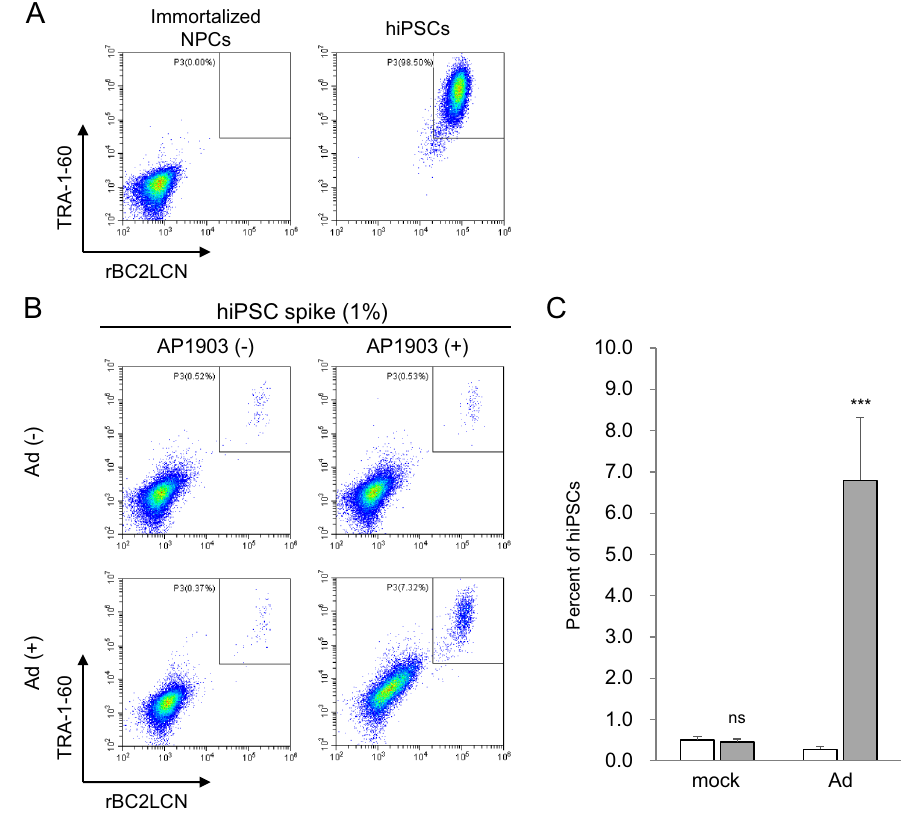
Figure 2. hiPSCs in cultures of immortalized NPCs are concentrated by treatment with the Ad vector and AP1903. Immortalized NPCs supplemented with hiPSCs at a ratio of 1% were treated with the Ad vector (3 pfu/cell) and AP1903. After treatment, the binding levels of rBC2LCN and the expression levels of TRA-1–60 were determined by flow cytometry. Representative pseudo color plots of the data from three independent experiments are shown ( A , B ). The percentages of hiPSCs in immortalized NPCs are shown as means ± SD of three independent experiments (open column, without AP1903; filled column, with AP1903) ( C ). Statistical significance was determined by two-way ANOVA and SNK post-hoc test ( *** P < 0.005; ns, not significant vs. without AP1903, SigmaPlot Version